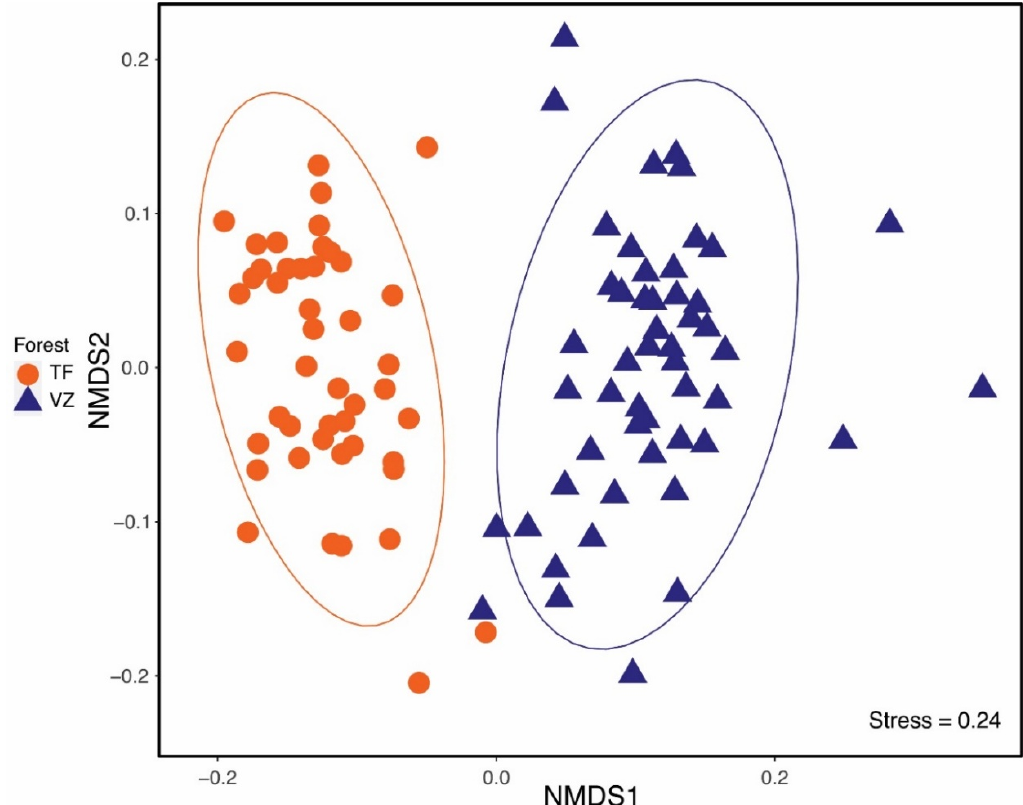
Figure 4. Non-metric multidimensional scaling (NMDS) ordination showing the relative position of inventory plots in terra firme forest (orange circles) and várzea forests (dark blue triangles), along axes NMDS1 and NMDS2. Ellipses represent 95% confidence intervals (CI) around group centroids. Plot positions within ordination space are based on Bray-Curtis dissimilarities. The stress measure indicates similarity of observed distance to ordination distance.